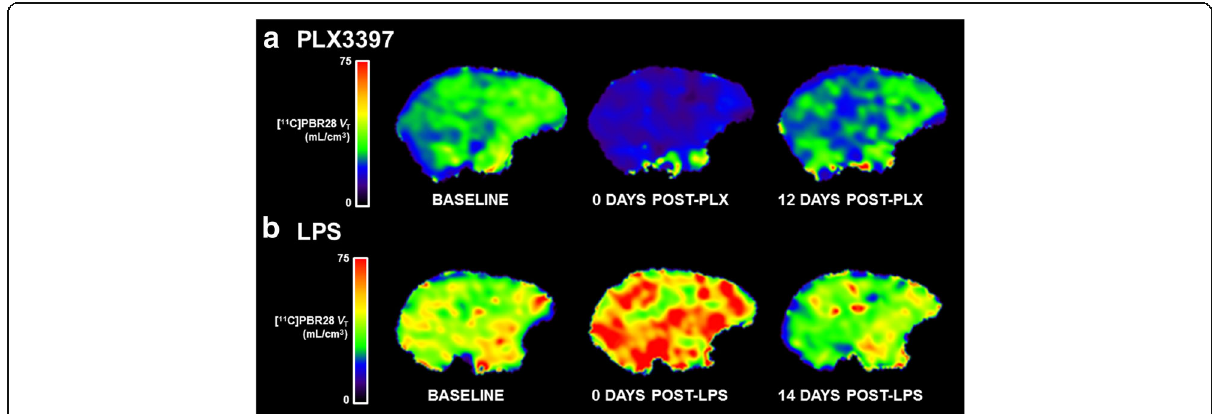
Fig. 1 Imaging microglial depletion and activation with [ 11 C]PBR28 PET. a Parametric images of [ 11 C]PBR28 V T at baseline ( left ), acutely post-PLX3397 (microglial depletion, center ), and 12 days post-PLX3397 (recovery, right ). b Parametric images of [ 11 C]PBR28 V T in a different animal at baseline ( left ), 2.5 h post-LPS (microglial activation, center ), and 14 days post-LPS (recovery, right ). All V T parametric images are in units of milliliters per cubic